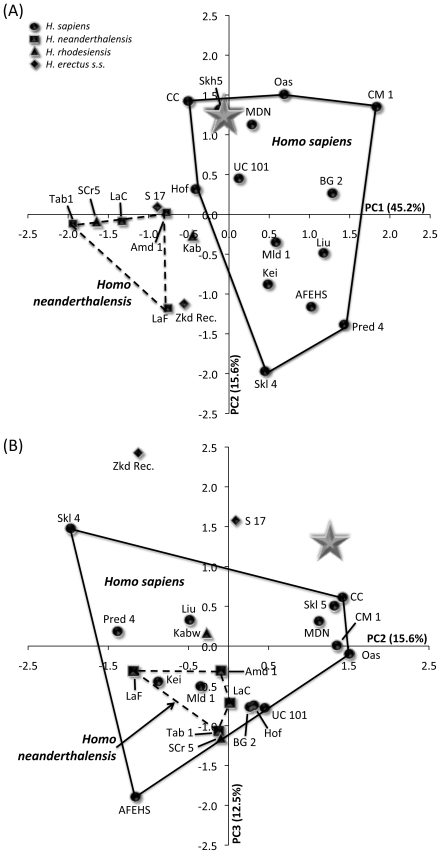
Object plots from principal components analysis including LL 1 and 23 later Pleistocene fossil crania.(A) PC 1 versus 2, and (B) PC 2 versus PC 3 (NB: Gray star = LL 1; AFEHS = African early H. sapiens; Amd = Amud; BG = Barma Grande; CC = Combe Capelle; CM = Cro Magnon; Kei = Keilor; Hof = Hofmeyr; Kab = Kabwe; LaC = La Chapelle; LaF = La Ferrassie; Liu = Liujiang; MDN = Mai Da Nuoc; Mld = Mladec; Oas = Oase; Pred = Predmost; S = Sangiran; SCr = Sima de Los Huesos cranium; Skh = Skhul; Tab = Tabun; UC = Upper Cave-Zhoukoudian; and Zkd = Zhoukoudian ERECT).